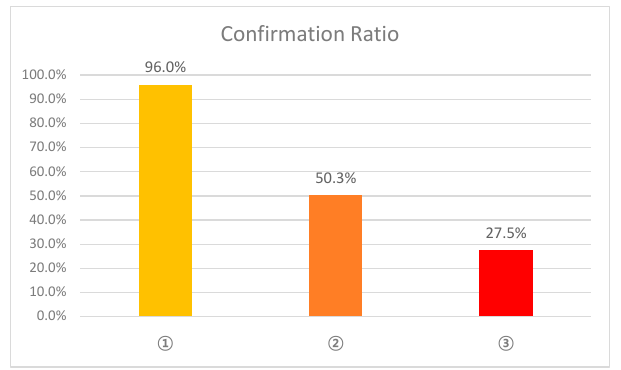
Figure 15. Confirmation ratio of each analysis method.